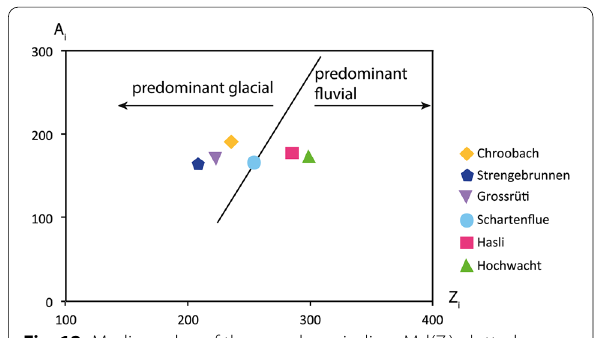
Fig. 12 Median value of the roundness indices Md(Z i ) plotted against median value of the flattening indices Md(A i ). The black line indicates the transition from fluvially dominated to glacially dominated transport (after Schlüchter, 1976)